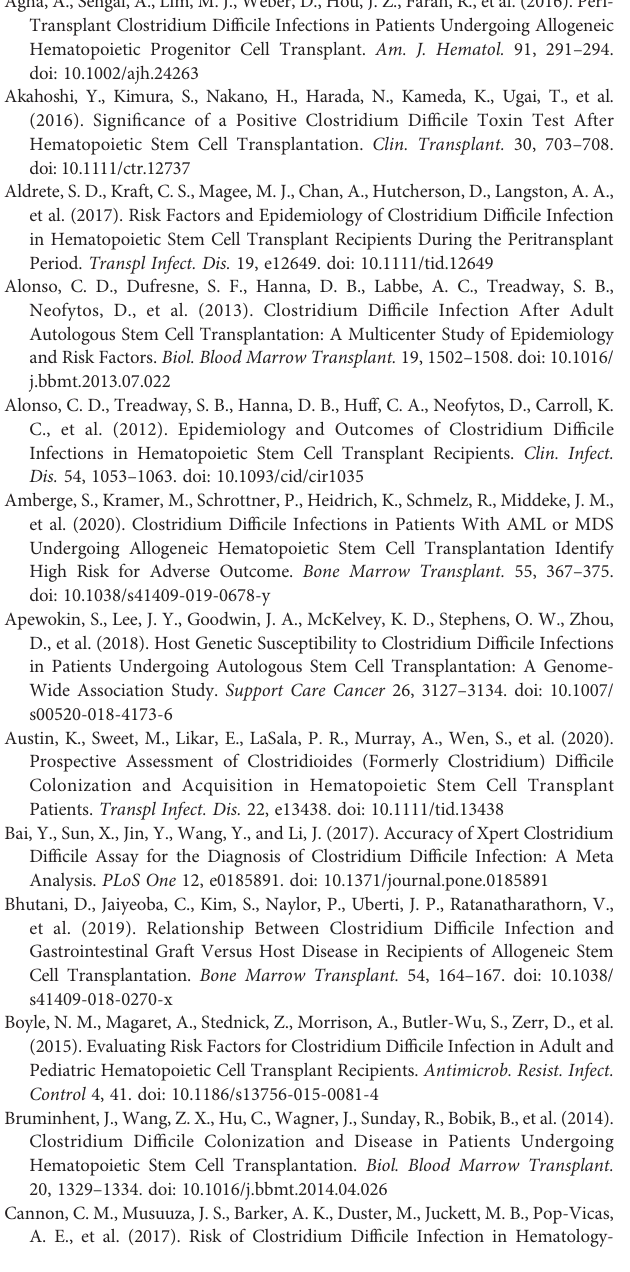
Supplementary Figure 2 | Prevalence of CDI among allogeneic (A) and autologous (B) HSCT recipients. Supplementary Figure 3 | Prevalence of CDI among studies in North America (A) , Asia (B) , and Europe (C) . Supplementary Figure 4 | Prevalence of CDI among studies with < 200 patients (A) and studies with ≥ 200 patients (B) . Supplementary Figure 5 | Prevalence of CDI in prospective studies (A) and retrospective studies (B) .